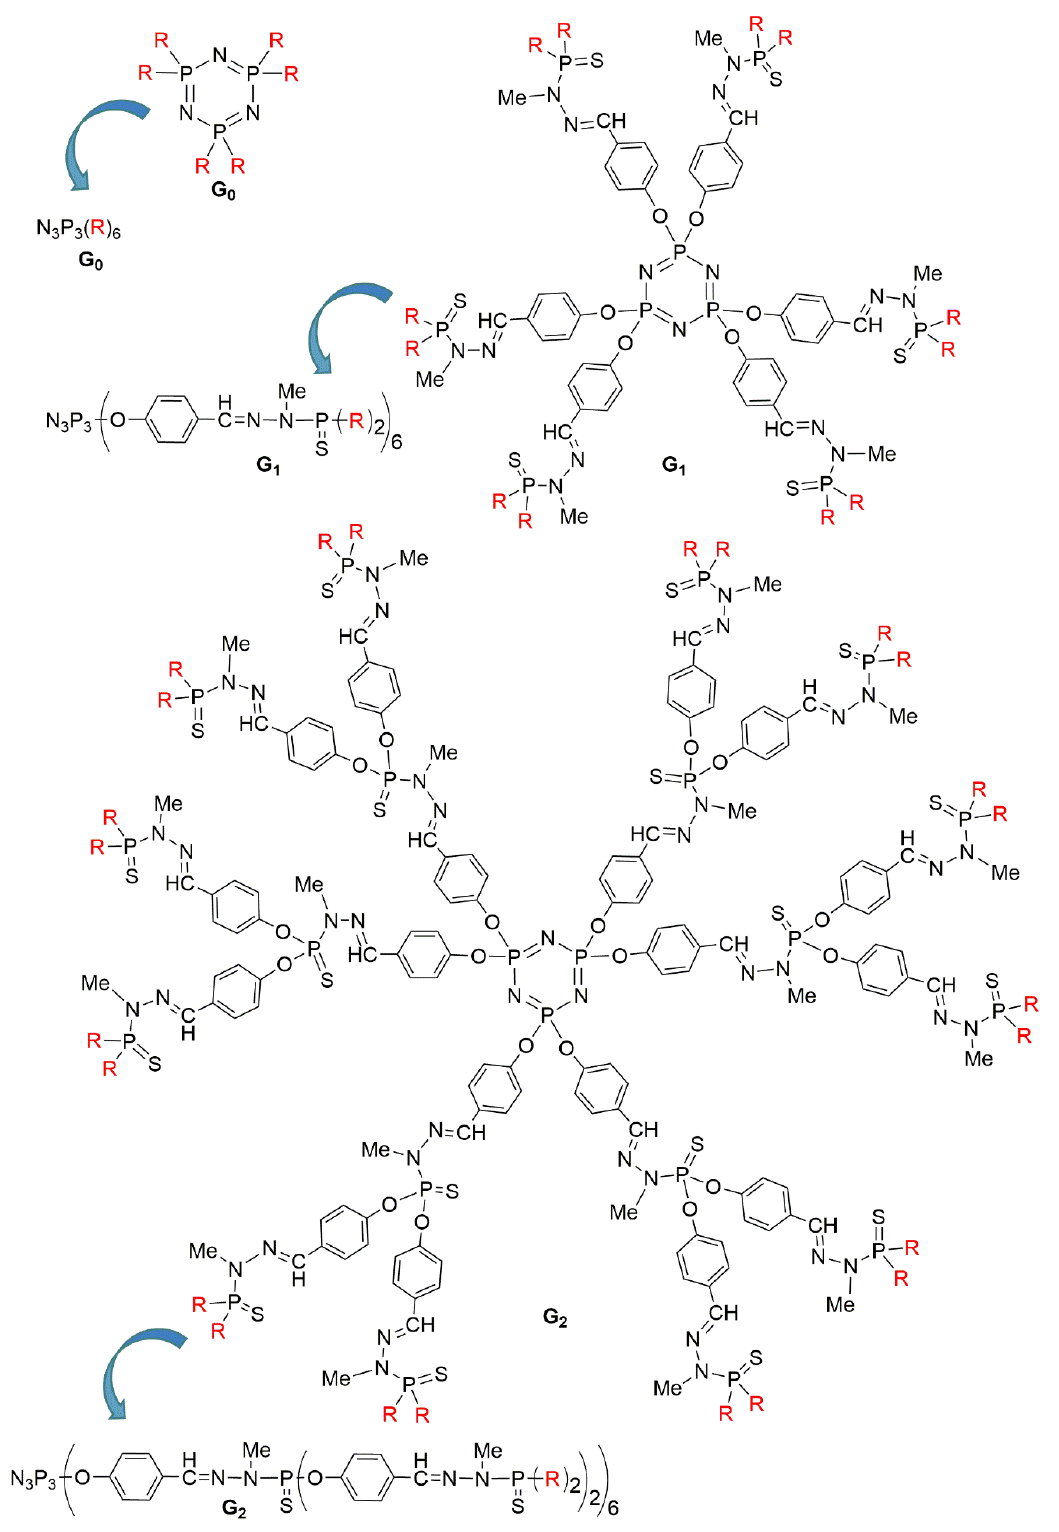
Figure 1. Full chemical structure of phosphorhydrazone dendrimers of generations zero ( G 0 ), one ( G 1 ), and two ( G 2 ). For each dendrimer, the same structure is shown in a linear form with parentheses at each level of branching. The linear structure will be used in all the following Figures.